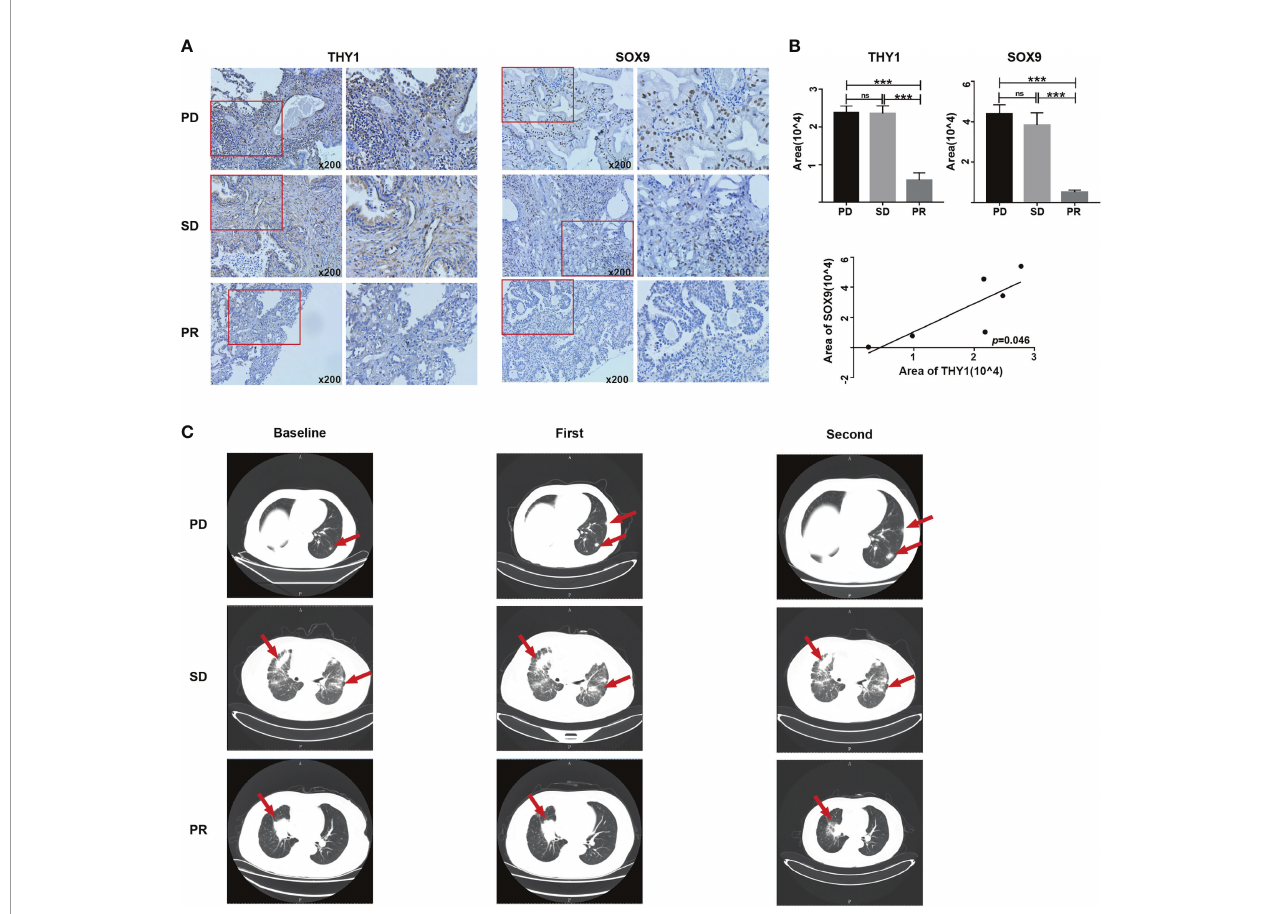
FIGURE 7 | The expression levels of THY1 are signi fi cantly associated with SOX9 and ef fi ciency of PD-1 mAb treated LUAD patients. (A) Representative immunohistochemical staining of THY1 and SOX9 on tumor tissues of LUAD patient receiving PD-1 mAb treatment. Original magni fi cation, 200×. (B) Statistic analysis of immunohistochemical staining score of THY1 and SOX9. Correlation analysis of the immunohistochemical staining score of THY1 and SOX9. ns, no signi fi cance; *** p < 0.001. (C) Representative CT results of LUAD patients before and after receiving PD-1 mAb treatment. PD, progressive disease; SD, stable disease; PR, partial